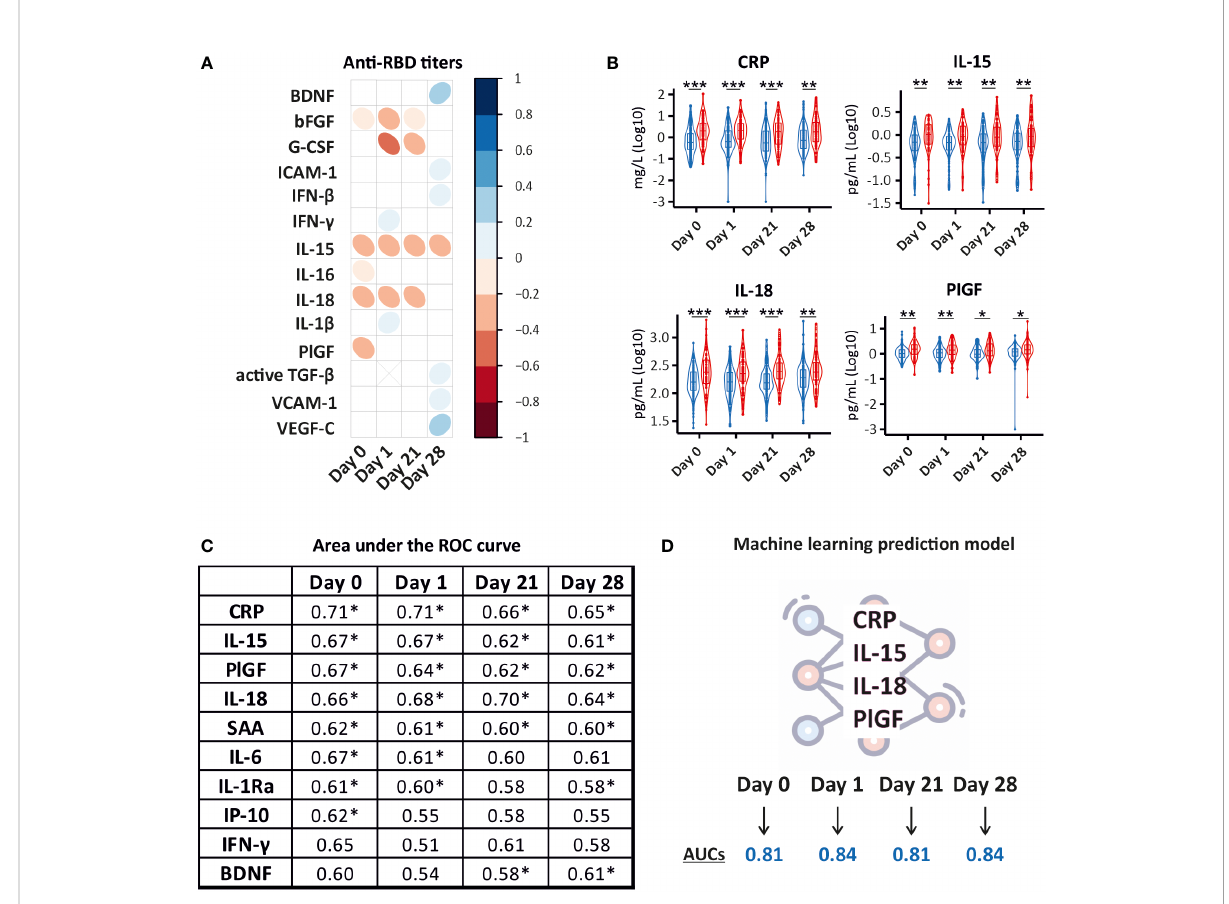
FIGURE 4 Prediction models for BNT162b2 immune response in cancer patients. (A) Correlation matrix depicting the correlation between CCG measurements (log 10 transformed) and quantitative anti-RBD IgG measurements at day 49. IgG antibody levels to SARS-CoV-2 RBD antigen were assessed with an enzyme-linked immunosorbent assay for quantitative detection of IgG antibody levels to SARS-CoV-2 RBD antigen. Only CCGs with signi fi cant correlations are shown. (B) Signi fi cantly different between good ( ≥ 200 IU/mL) (blue) and poor (< 200 IU/mL) (red) responders to the BNT162b2 vaccine. A good/poor responder threshold of anti-RBD IgG titer of 200 IU/mL used in this study predicts a neutralization response required for 50% protection against symptomatic SARS-CoV-2 infection (99%-100% speci fi city at a sensitivity of 95%). * p < 0.05, ** p < 0.01, *** p < 0.001. (C) Area Under the Receiver Operating Characteristic (AUROC) values for 10 predictors of the binary IgG response as good or poor responders at day 0, day 1, day 21, and day 28. * Denotes signi fi cant p -values of at least < 0.05. (D) Random Forest Classi fi er predicted a model where a combination of CRP, IL-15, IL-18, and PlGF levels measured right before vaccine administration (day 0) and at day 1, day 21, and day 28 after the primer dose predicted good and poor responders with high accuracy (AUCs depicts averages of 10 individually constructed ROC